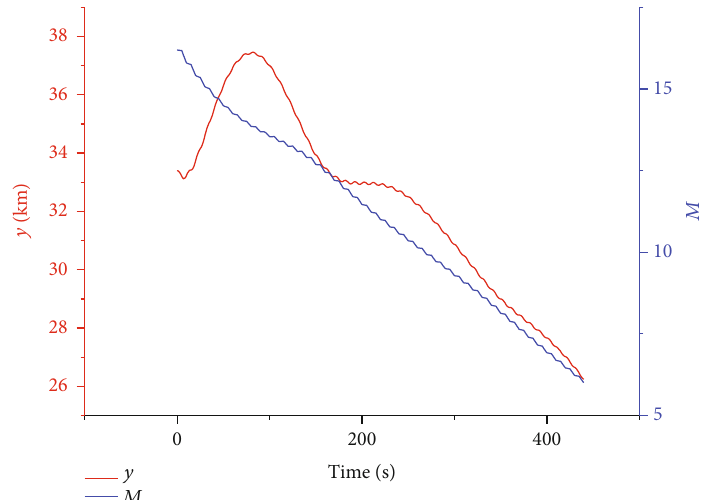
Figure 15: Altitude and Mach number with self-oscillation